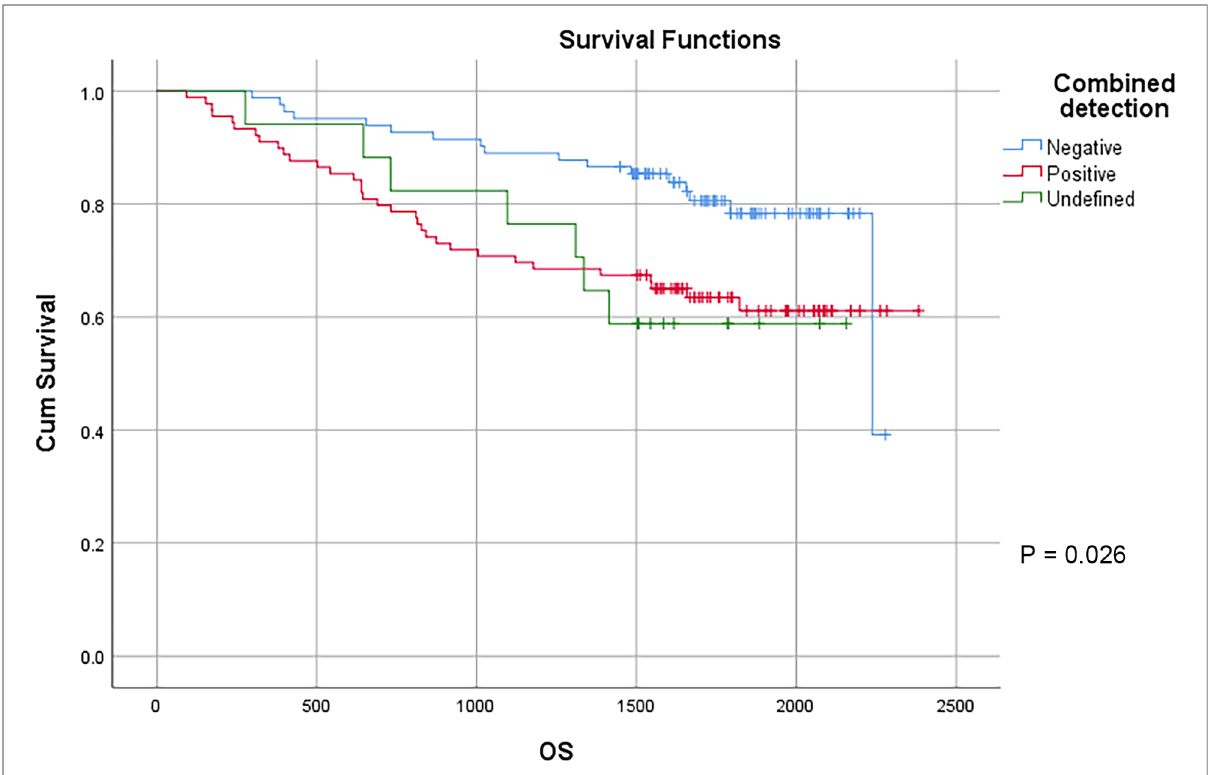
FIGURE 7 Survival curves of colon cancer patients in different combined detection groups.